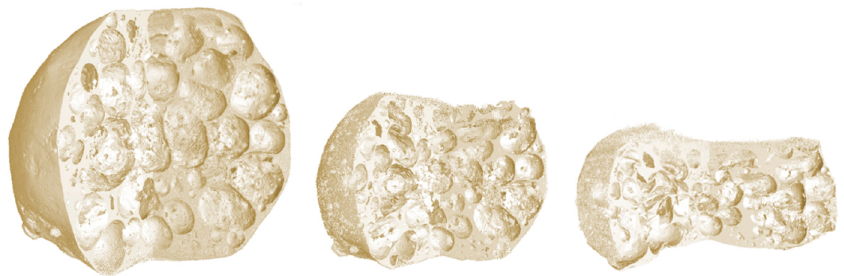
Figure 3. Visualisation of a deformed APM sphere—reconstructed 3D image captured after loading steps 1, 13 and 25.